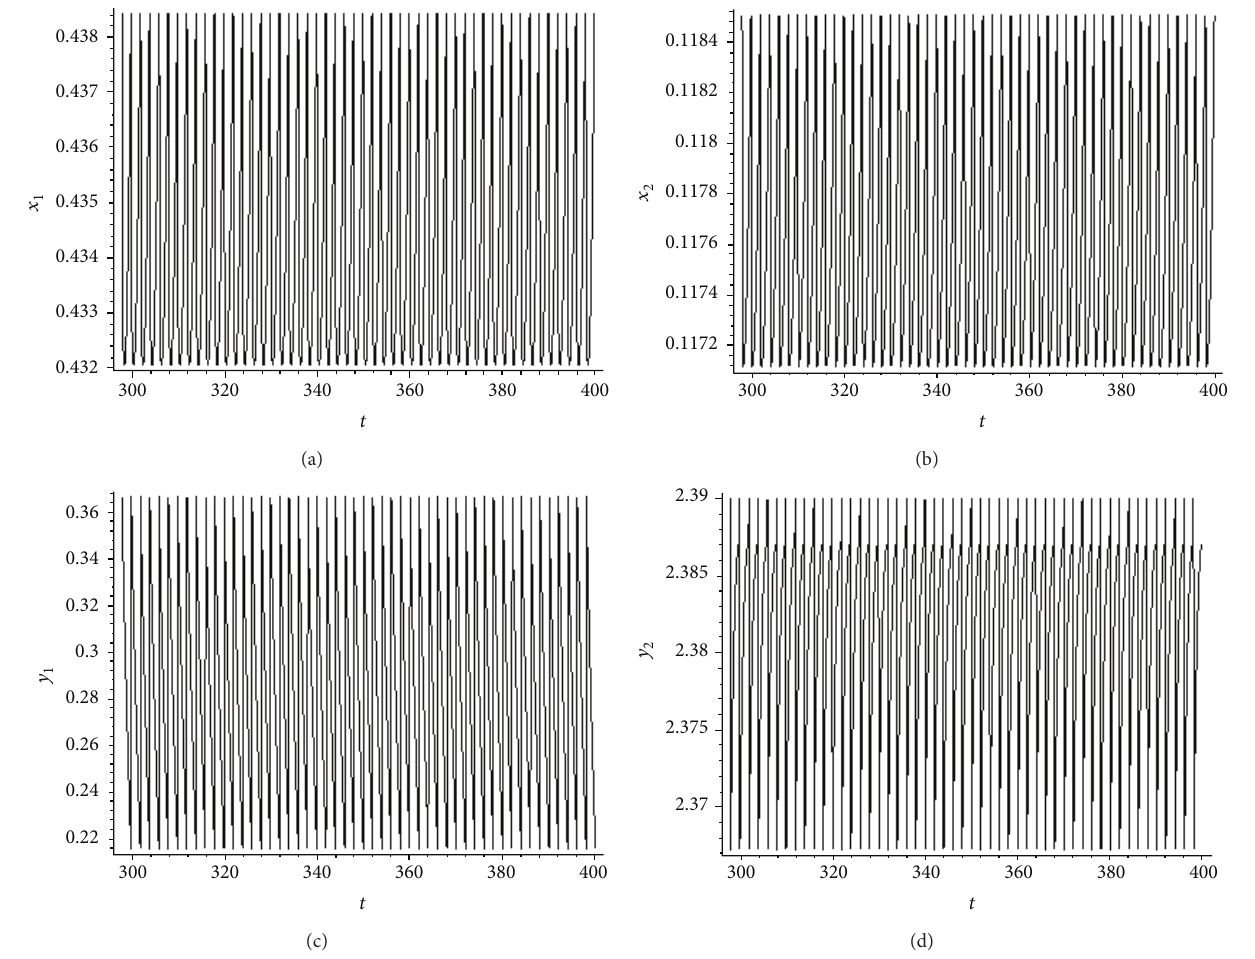
Figure 2: The permanence of system (3). (a, b) Time series of prey populations 𝑥 1 (𝑡) , 𝑥 2 (𝑡) and (c, d) time series of predator populations (𝑡) , 𝑦 (𝑡) with initial values 𝑥 𝑦 1 2